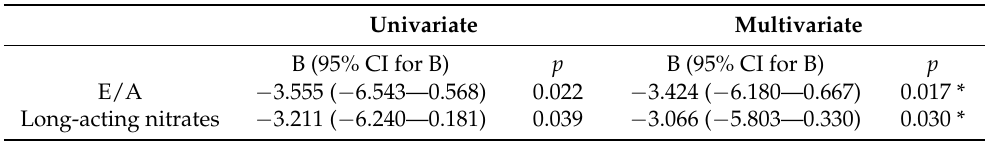
Table 8. Univariate and multivariate regression analysis demonstrating the relationship between baseline characteristics and galectin-3 concentration on day 30 in